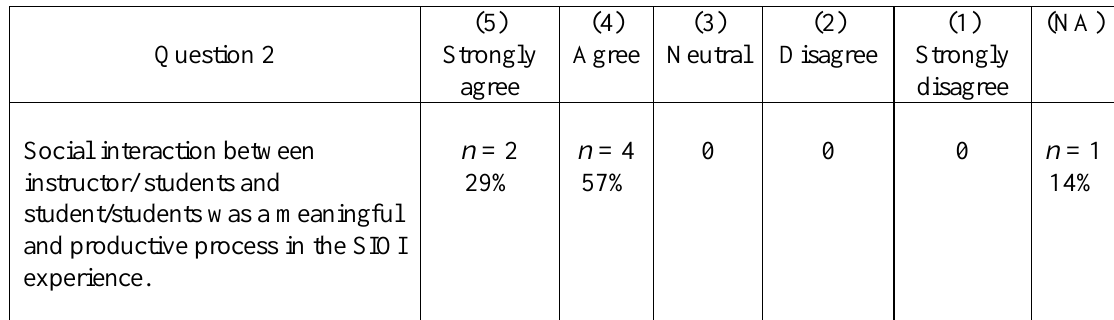
The Nature of Social Interaction in SIOI